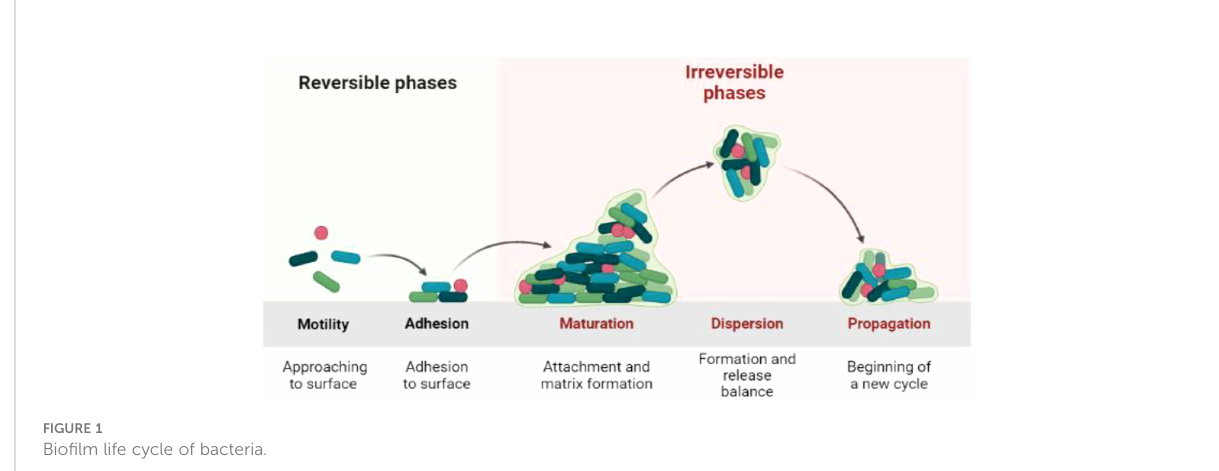
FIGURE 1 Bio fi lm life cycle of